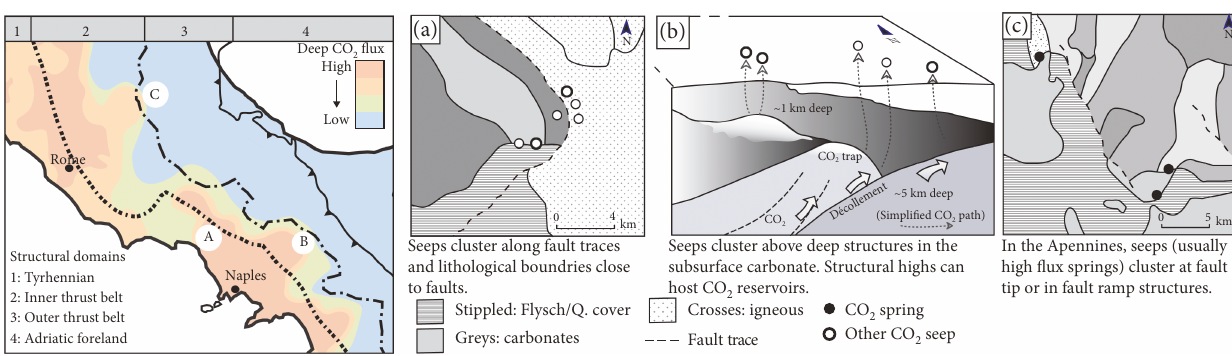
Figure 3: Map of Central Italy showing CO seepage in the major structural domains [17], distribution of deep CO 2 of three examples illustrating the range of structural controls on CO seeps within the three domains of degassing. The speci fi c lithologies in 2 (a) and (c) are not indicated here but can be found from [59]. The three scenarios are not mutually exclusive.